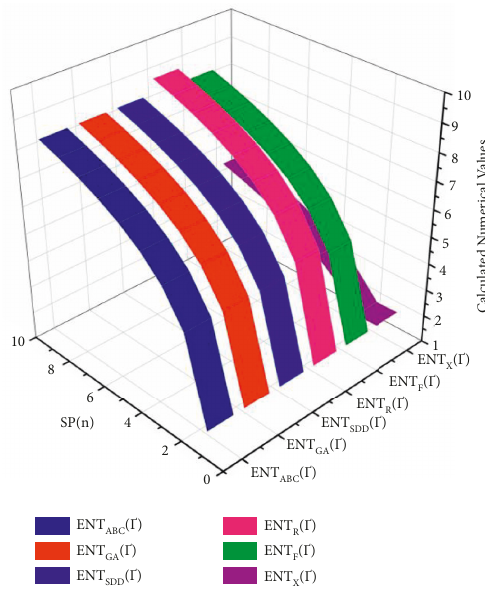
Figure 6: 3D visualisation of Table